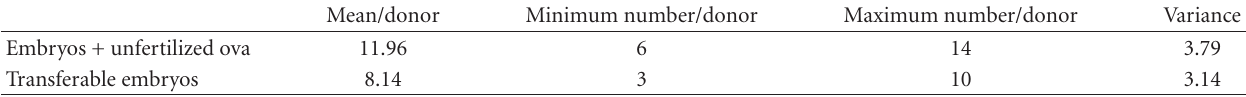
Table 2: The male-female distribution of pregnancies/calves according to the developmental stage of the embryos at the moment of biopsy and transfer. Biopsied and transferred